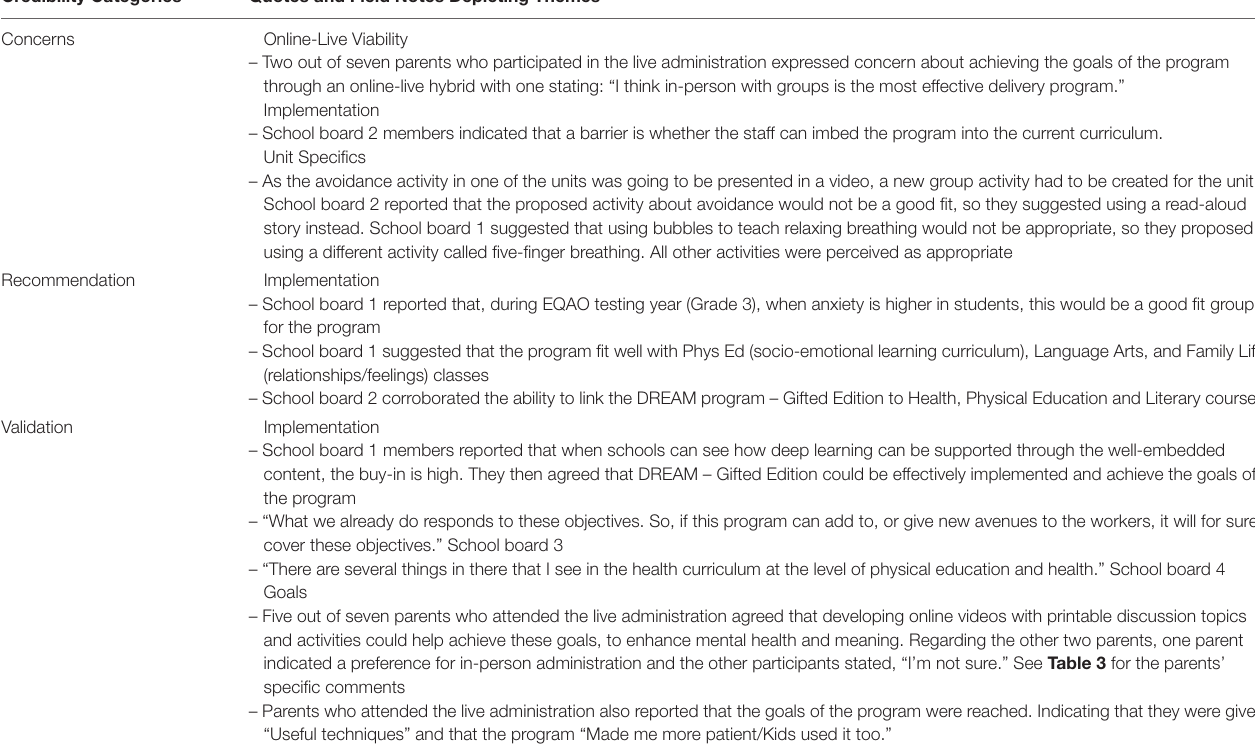
TABLE 4 | Credibility qualitative